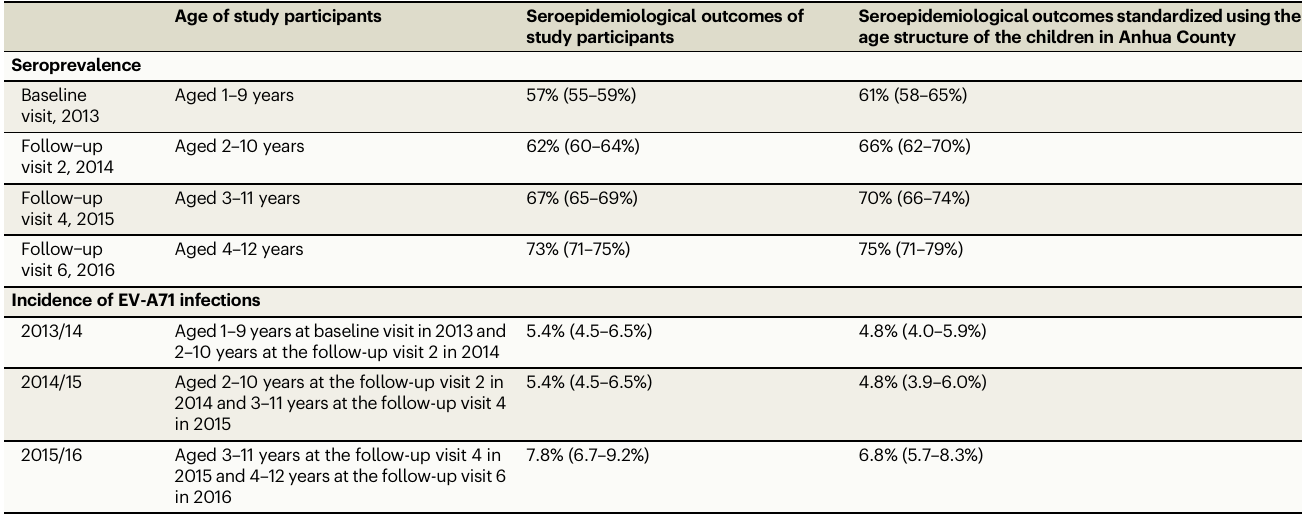
Table 2 | Seroprevalence and incidence of EV-A71 infections by serology in study participants of the Children cohort and that standardized using the age structure of the children in Anhua County (a cutoff titre of 16) Age of study participants Seroepidemiological outcomes of study